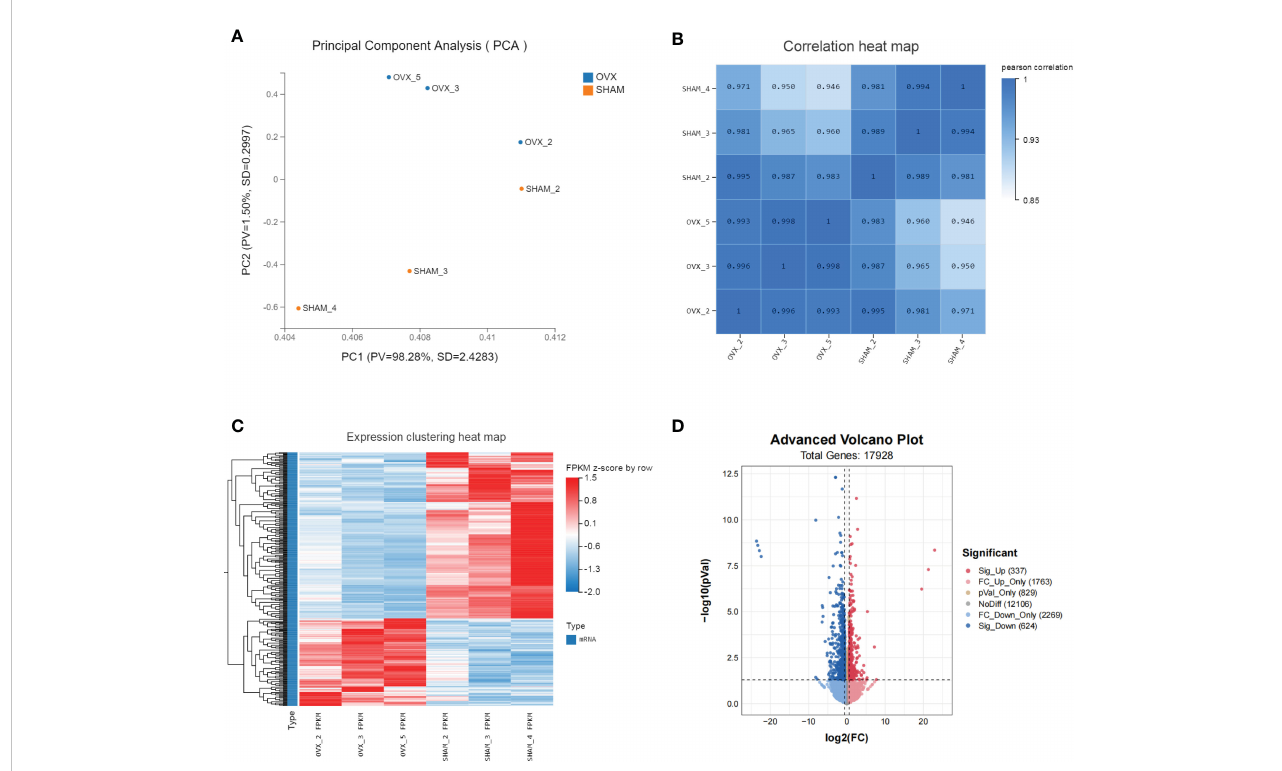
FIGURE 3 Identi fi cation of dif-mRNAs of GAS in SHAM vs. OVX (valid biological replicates n=3 in each group). (A) Principal component analysis (PCA). (B) Correlation heat map. (C) Hierarchical clustering of mRNA sequencing showed mRNA differential expression pro fi les (|log 2 FC| ≥ 0.6, Q value <0.05). Each row indicates a single gene and each column indicates a sample. (D) Volcano plot of dif-mRNAs. Red dots represent signi fi cantly up-regulated mRNAs with log 2 FC ≥ 0.6, P value < 0.05. Pink dots represent up-regulated mRNAs with log 2 FC ≥ 0.6, P value ≥ 0.05. Brown dots represent up- regulated mRNAs with -0.6 < log 2 FC < 0.6, P value < 0.05. Grey dots represent stable mRNAs. Sky-blue dots represent down-regulated mRNAs with log 2 FC ≤ -0.6, P value ≥ 0.05. Blue dots represent signi fi cantly down-regulated mRNAs with log 2 FC ≤ -0.6, P value <